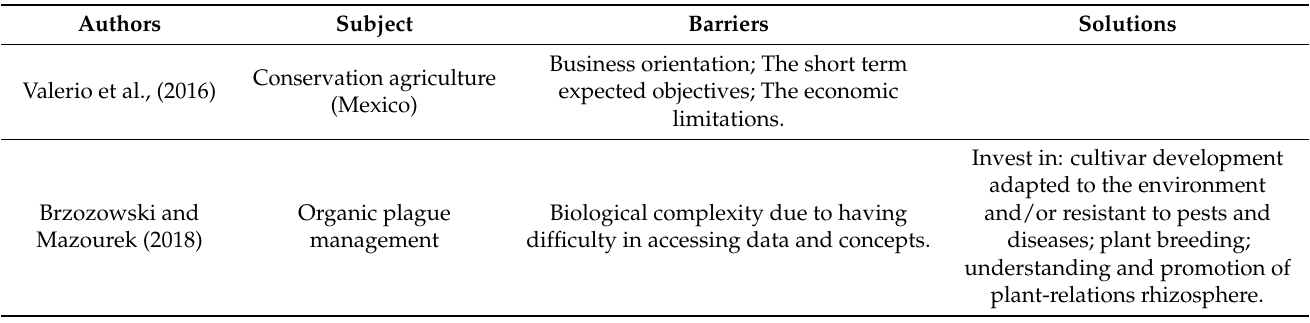
Table 1. Barriers and